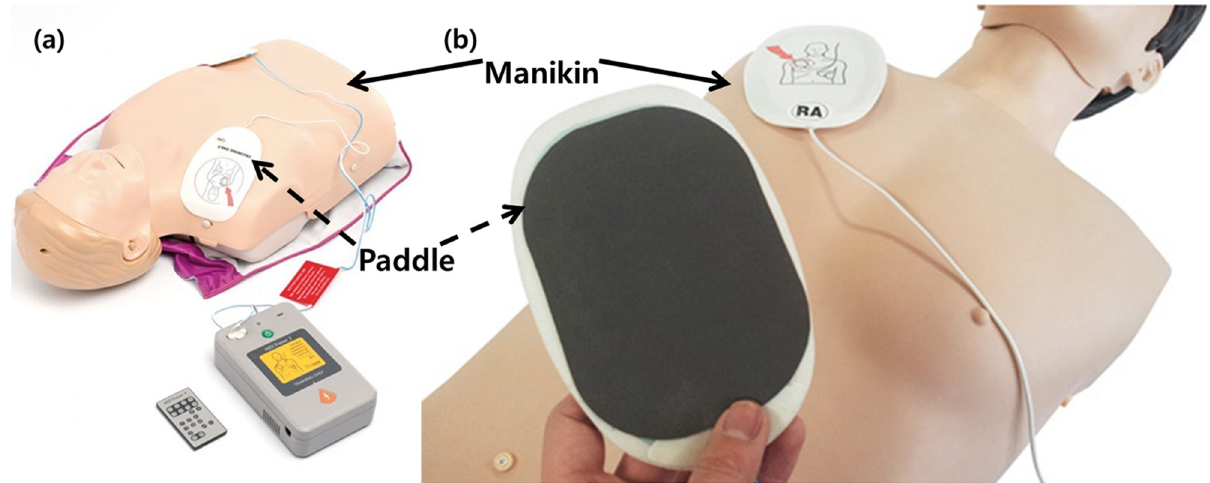
Fig 1. Example of CPR training simulators. (a) Laerdal–Anne; (b) BT–CPTA; Typical AED training devices are chest models and paddles as shown, which are mainly devices that include CPR and defibrillation related training functions.